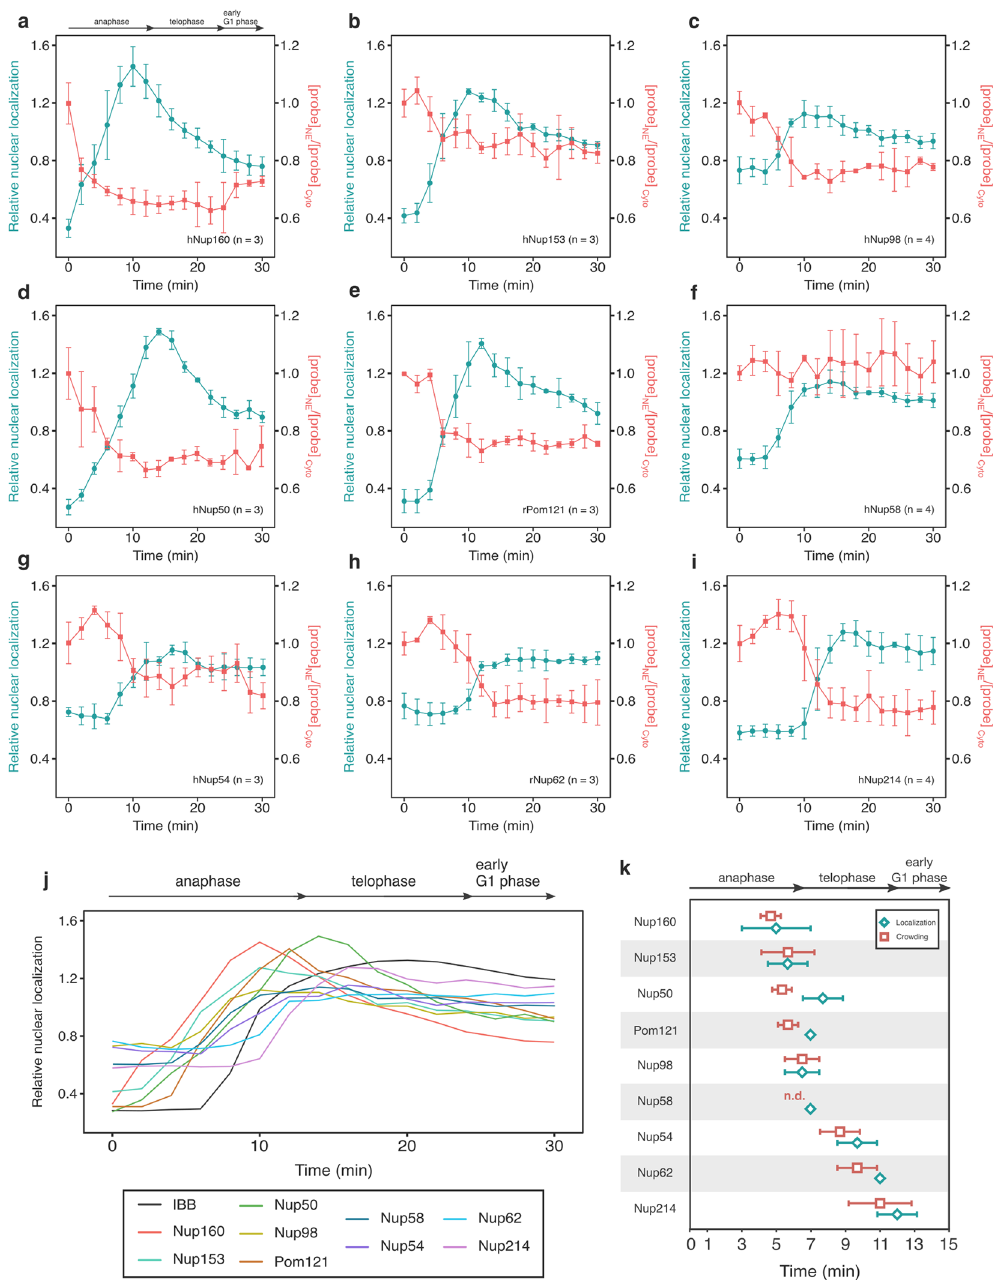
Figure 6. Time-lapse analysis of localization and crowding of Nups during mitosis. ( a–i ) Co-plot of Nup localization and protein crowding. The CFP signal on the chromosome surface was measured as a localization signal, and shown as the relative nuclear localization value as previously reported 59 . The relative localization signal (blue), and the probe signal ([probe] NE /[probe] Cyto , red) are co-plotted against time after anaphase onset, which was defined by the separation of chromosomes (mPlum-H3). The probe signal is presented as a relative value to that at time 0. The results from Nups 160 ( a ), 153 ( b ), 98 ( c ), 50 ( d ), Pom121 ( e ), Nup58 ( f ), 54 ( g ), 62 ( h ), and 214 ( i ) are shown. Data are represented as mean ± SD, with the number of the cells indicated ( n ) in the upper side of each panel. ( j ) Summary of the localization signals. Relative nuclear localization of CFP signals shown in the panel ( a–i ) are summarized. Representative fluorescence images are shown in Figure S5. The progression of mitosis is indicated at the top of the panel. For visibility of the graph, error bars are not shown here. ( k ) Summary of localization and probe signals during mitosis. The time when the localization signal and probe signal reached half maximum and minimum was extracted from results represented in Fig. 4a–i, and plotted against time after anaphase onset. Data are represented as mean ± SD from more than 3 independent experiments. Peak crowding of Nup58 (n.d) was not plotted because the probe signal did not significantly change during the observation ( f